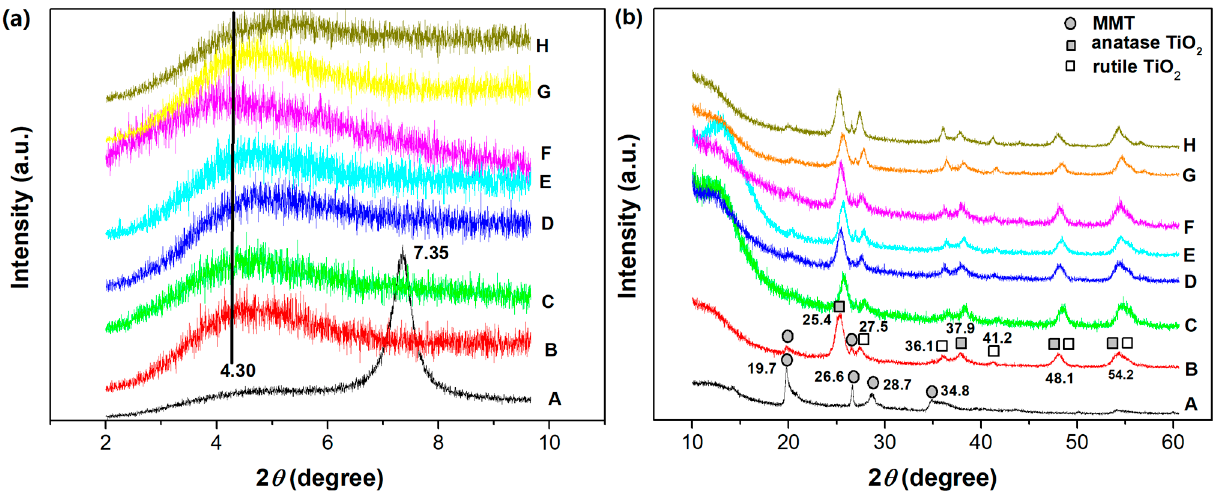
Figure 1. XRD patterns of the TiO 2 -MMT/PCN@Pd nanocomposites with 2 θ small angle from 2 to 10° ( a ) and wide angle from 10 to 60° ( b ): A . MMT; B . TiO 2 -MMT; C . TiO 2 -MMT 80 /PCN 20 ; D . TiO 2 -MMT 80 /PCN 20 @Pd 2+ ; E . TiO 2 -MMT 80 /PCN 20 @Pd 0 ; F . TiO 2 -MMT 60 /PCN 40 ; G . TiO 2 - MMT 60 /PCN40@Pd 2+ ; H . TiO 2 -MMT 60 /PCN 40 @Pd 0